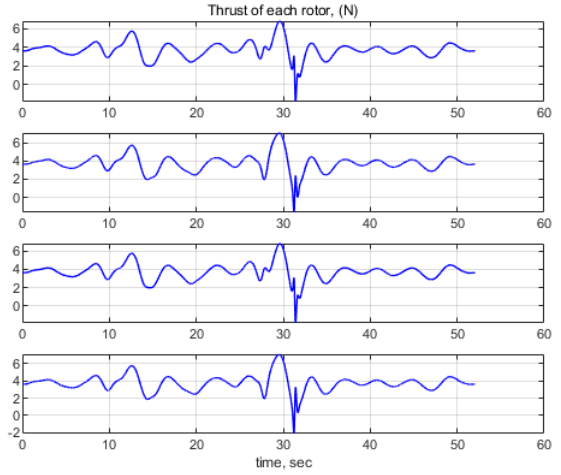
Figure 10. Changes in the thrust of the four motors quadrotor UAV.